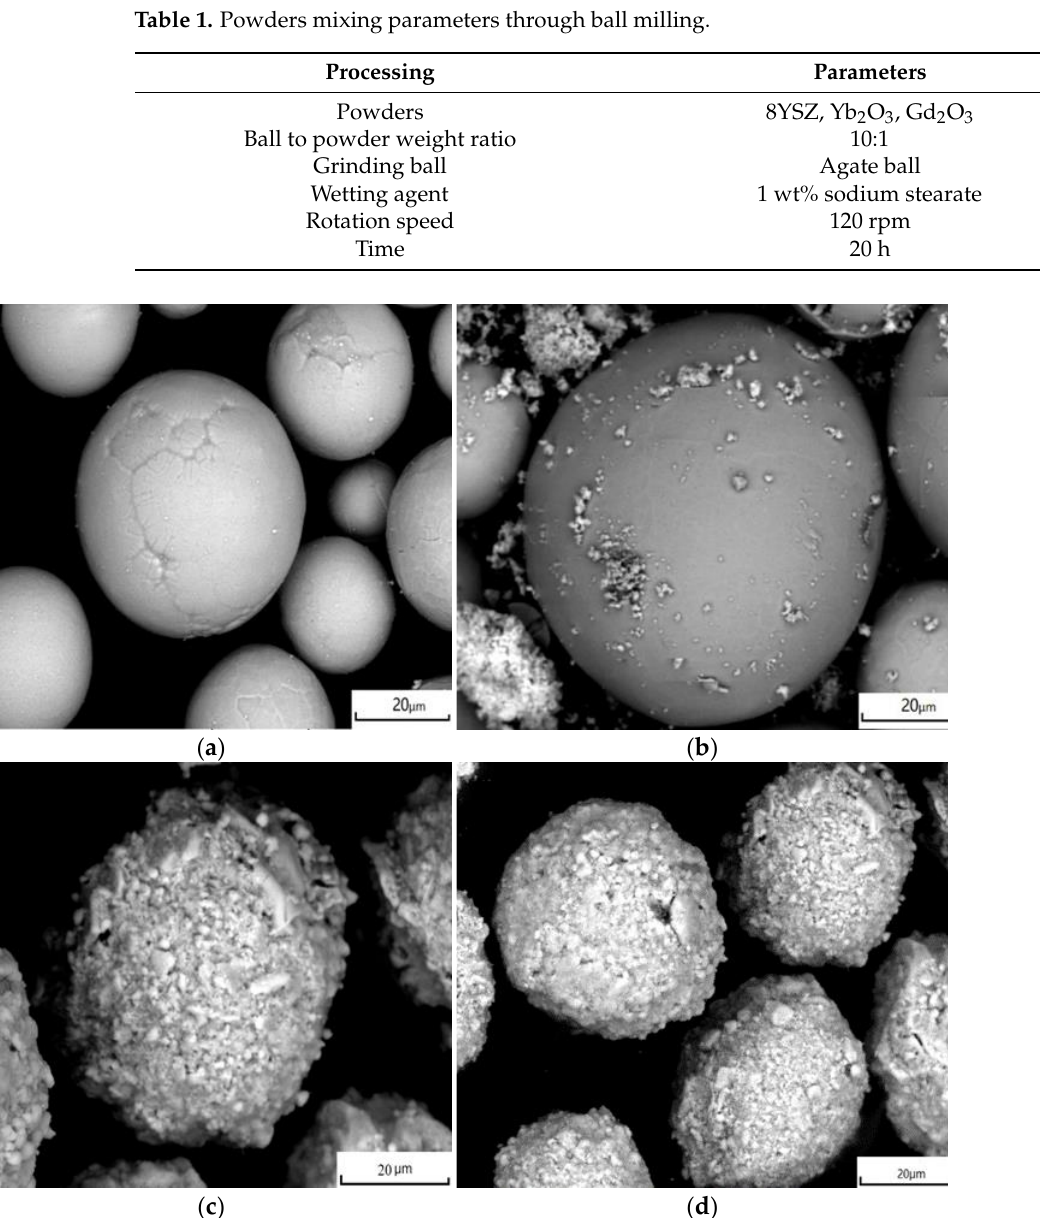
Figure 1. Morphology of powder: ( a ) 8YSZ; ( b ) GYYZO with 5 wt% Gd 2 O 3 and 5 wt% Yb 2 O 3 ; ( c ) GYYZO with 10 wt% Gd 2 O 3 and 5 wt% Yb 2 O 3 ; ( d ) GYYZO with 15 wt% Gd 2 O 3 and 5 wt% Yb 2 O 3 .